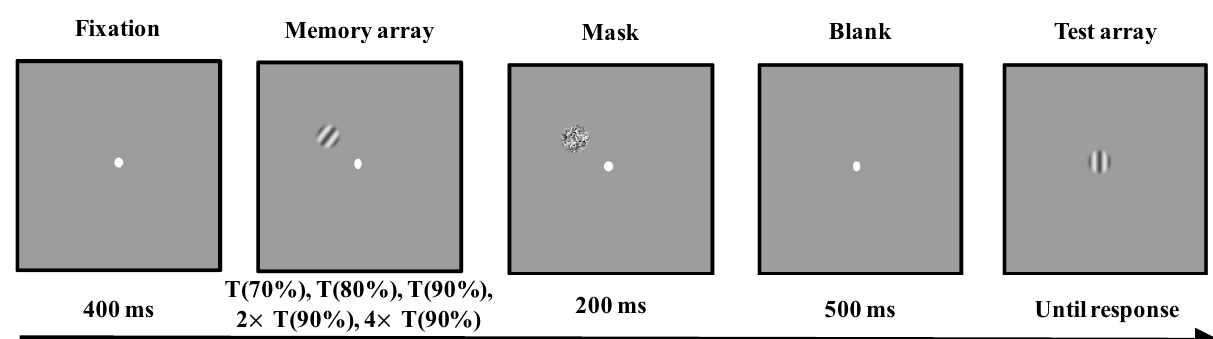
Figure 2. Trial structure of the main task in Experiment